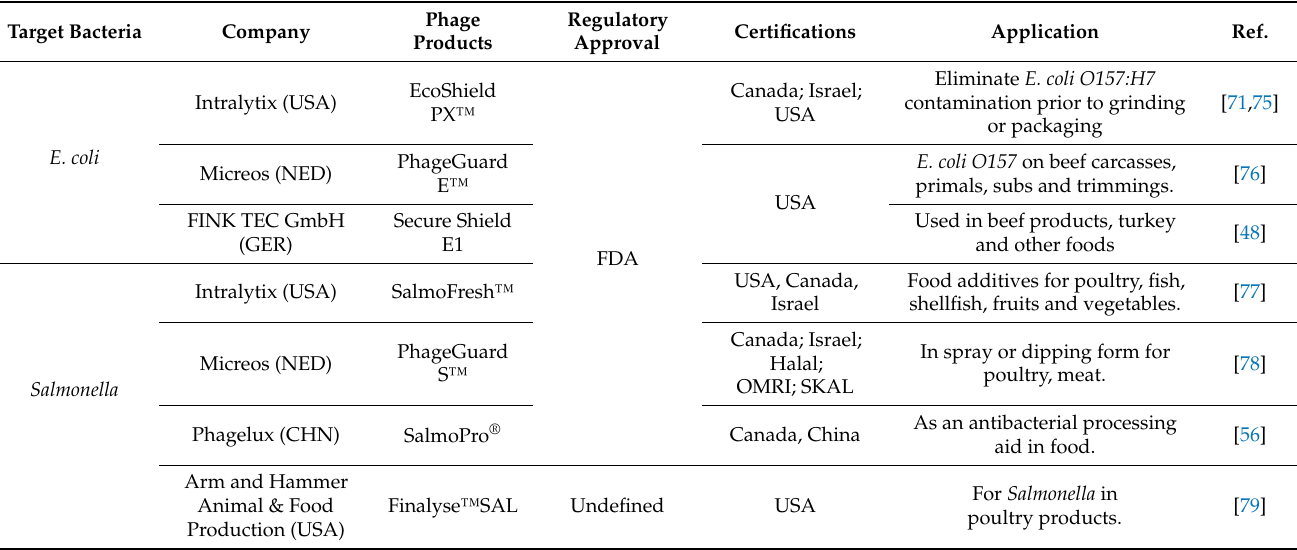
Table 3. Commercial phage products fighting foodborne pathogens in